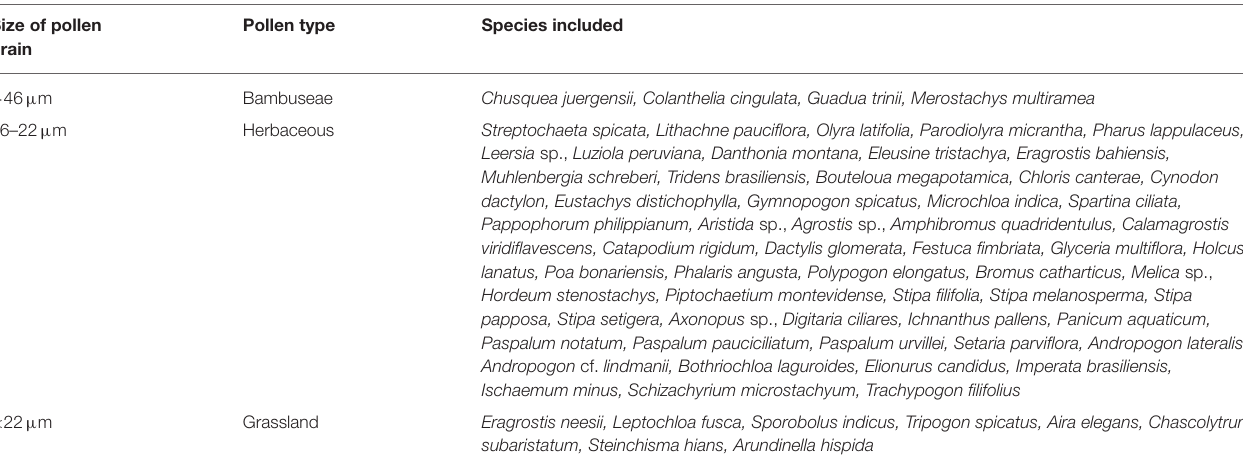
TABLE 6 | Pollen measures and establishment of pollen